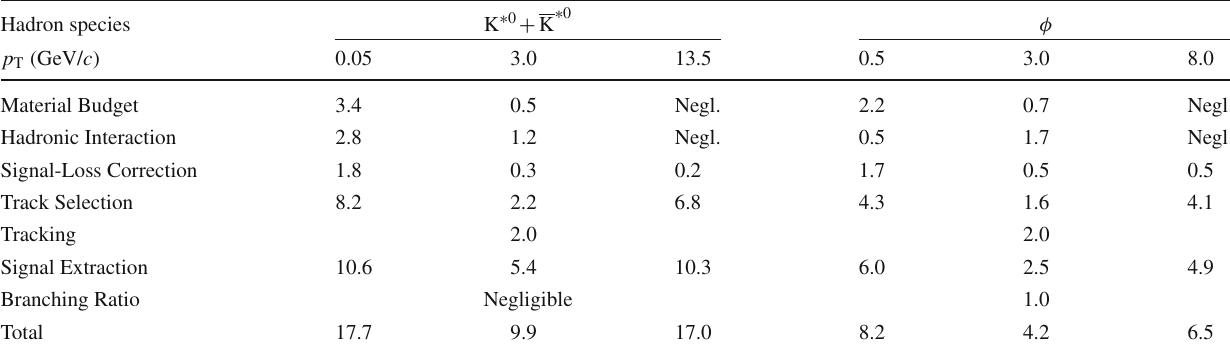
value between two or three columns indicates the mean for all p T bins, ∗ 0 with little p T dependence. The values are reported for low, intermediate and φ . A single and high p T . The abbreviation “negl.” indicates a negligible value